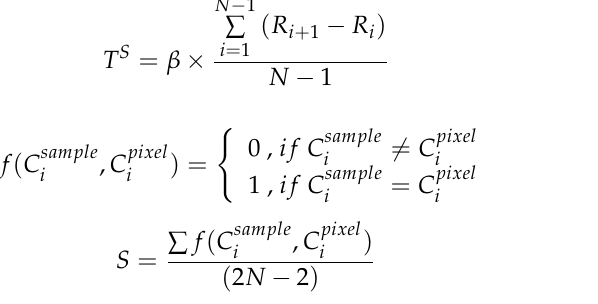
Table 1. The spectral shape patterns and their code words. Spectral Shape Pattern Code Word